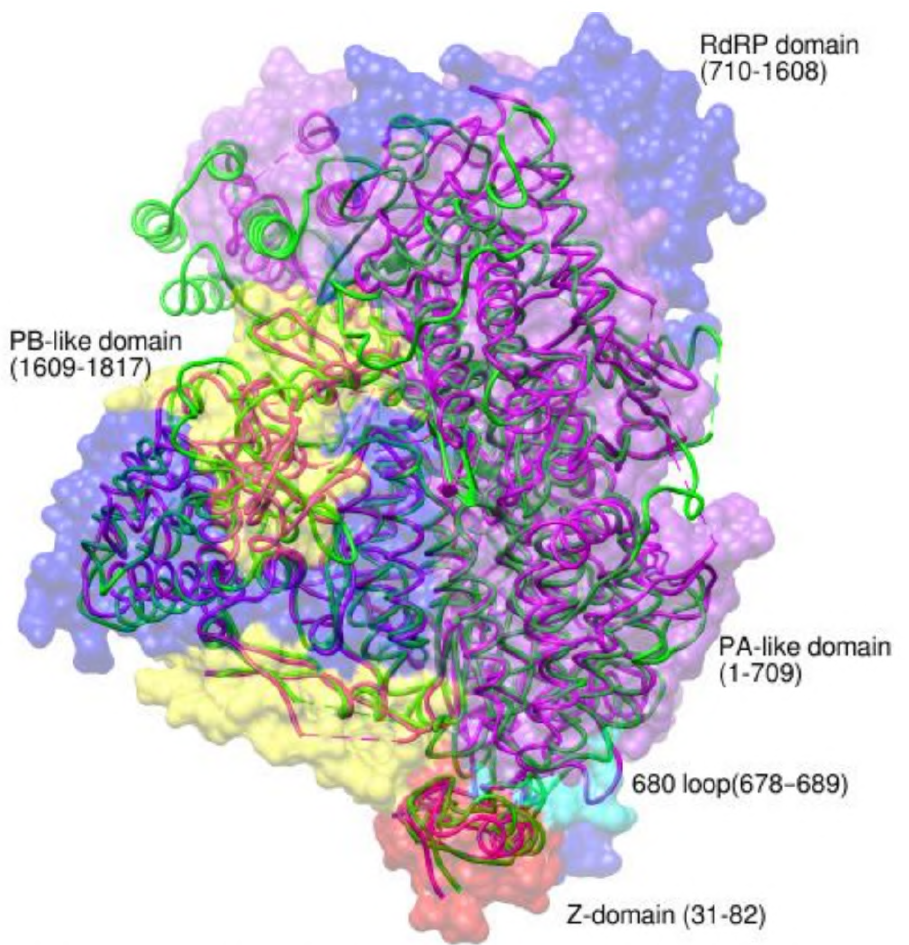
Figure 5. Superposition of Junin, LACV, and MACV L–Z complexes. The Junin RdRP complex showing the PA-like (purple), RdRP (blue), and PB2-like (yellow) domains. The PA-like domain harbors the endonuclease (residues 1-196). The Z-protein that acts like a molecular switch is shown in red color while the loop-680 that binds to the host factors is shown in cyan. The superposed structures of the L and Z proteins of LASV (green ribbons) and MACV (pink ribbons) indicate variability at the